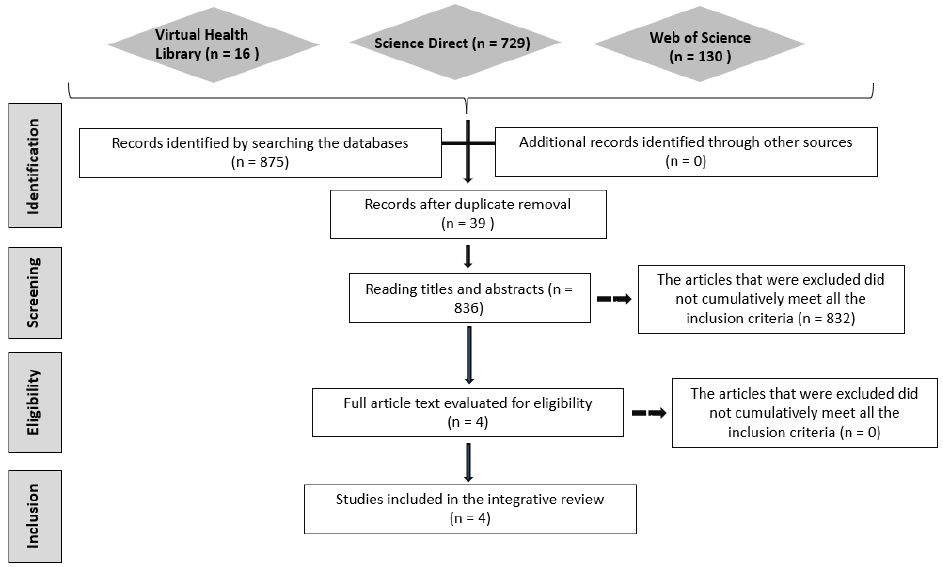
Figure 1. Article selection flowchart.